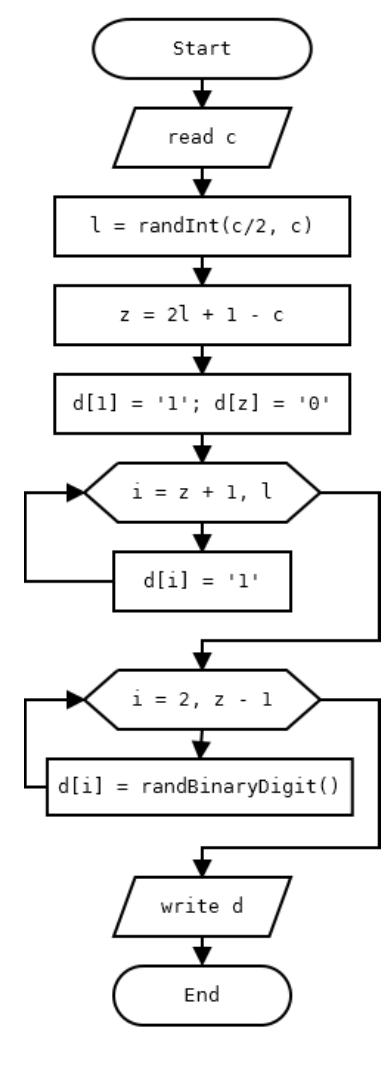
Figure 4. Algorithm of constructing the test